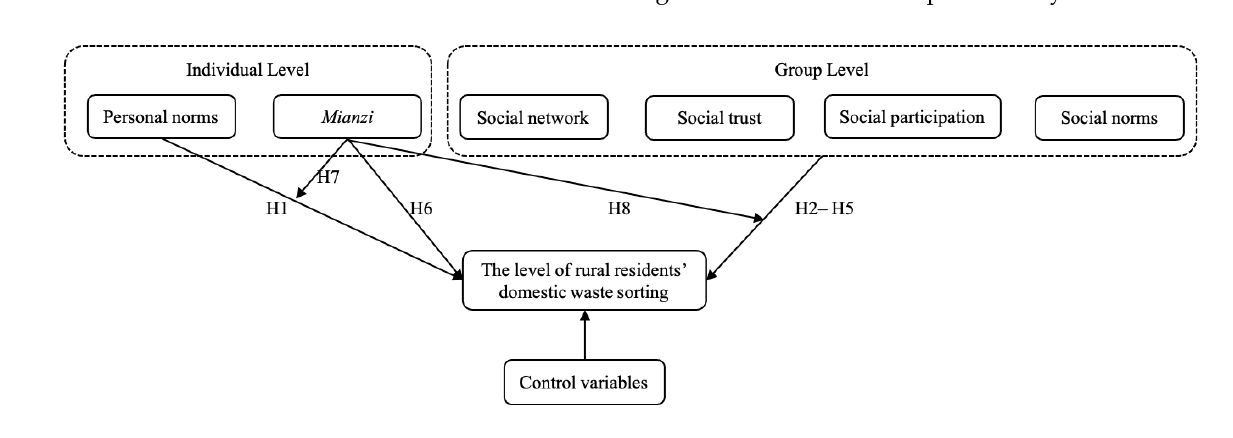
Figure 1. Conceptual framework and research hypotheses in the study.